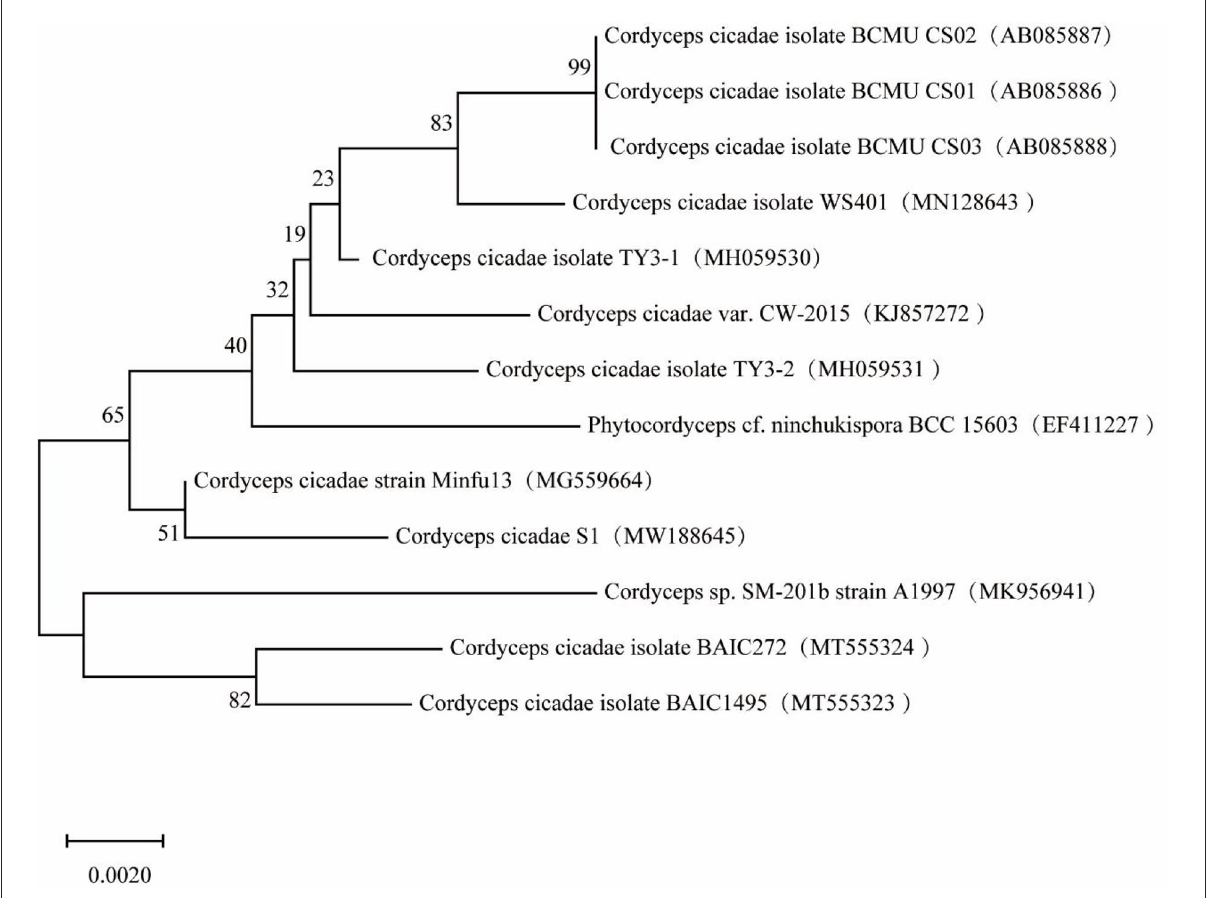
FIGURE2 Phylogenetic tree based on strain S1 sequence.